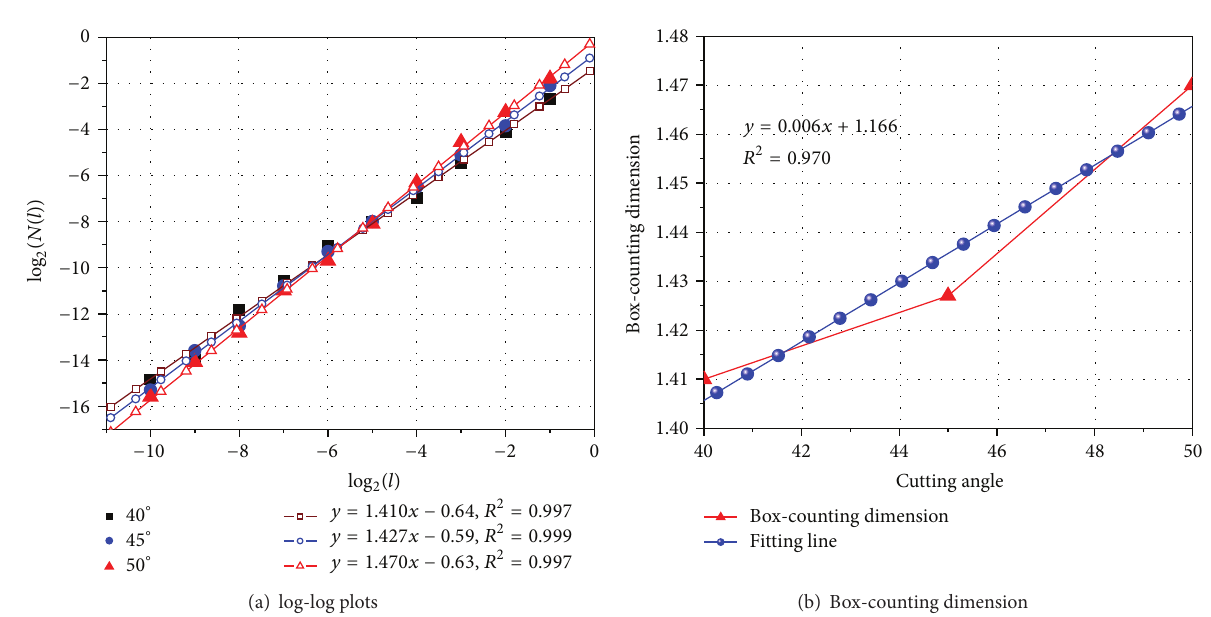
Figure 9: Box-counting dimension of cutting load under different cutting